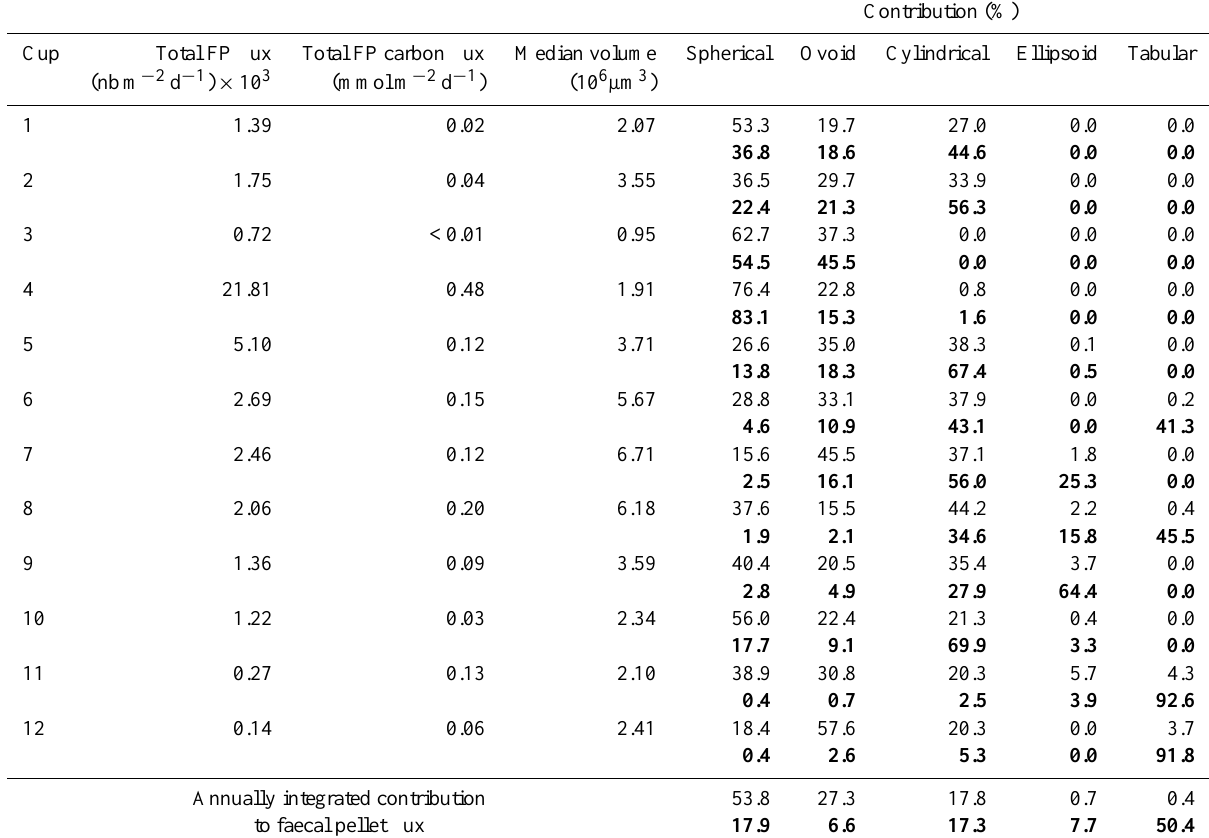
Table 6. Faecal pellet numerical fluxes (normal text) and contribution to faecal pellet carbon fluxes (bold) from the station A3 sediment trap. Contribution (%) Cup Total FP flux Total FP carbon flux Median volume Spherical Ovoid Cylindrical Ellipsoid